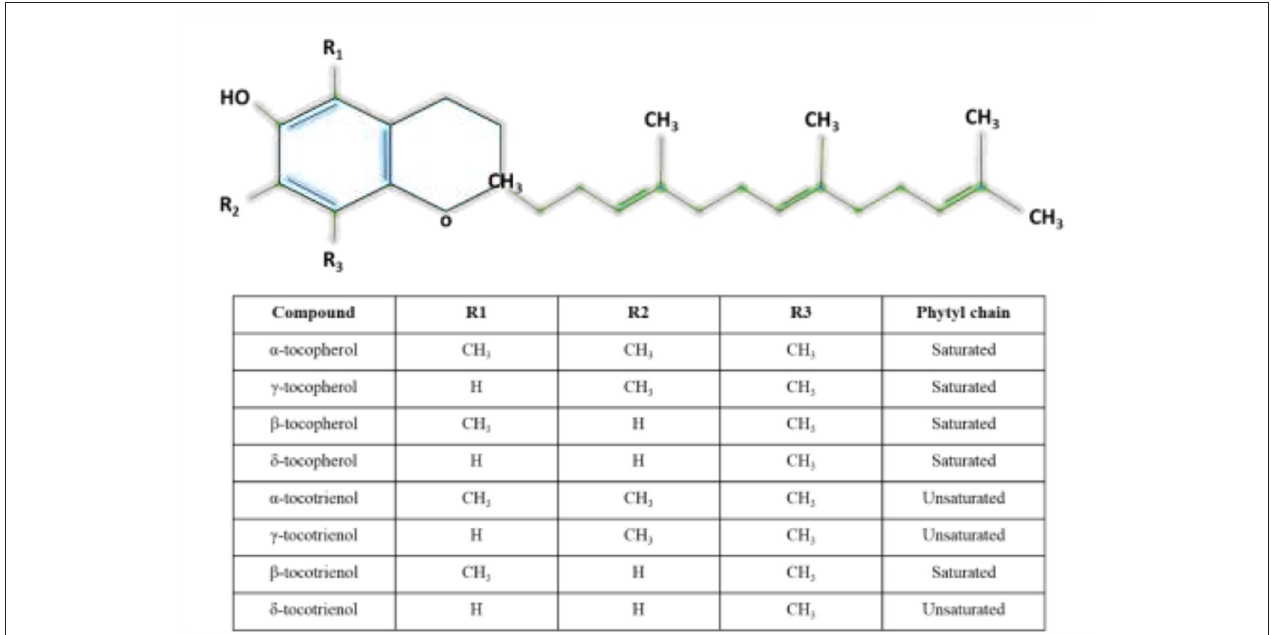
FIGURE 1 | Structures of tocotrienols and